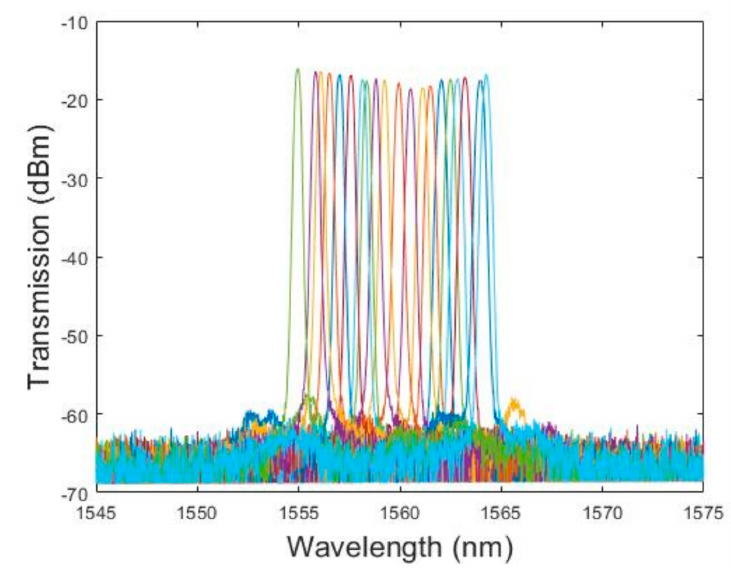
Figure 2. Superimposed laser spectra of the tunable erbium-doped fiber lasers.